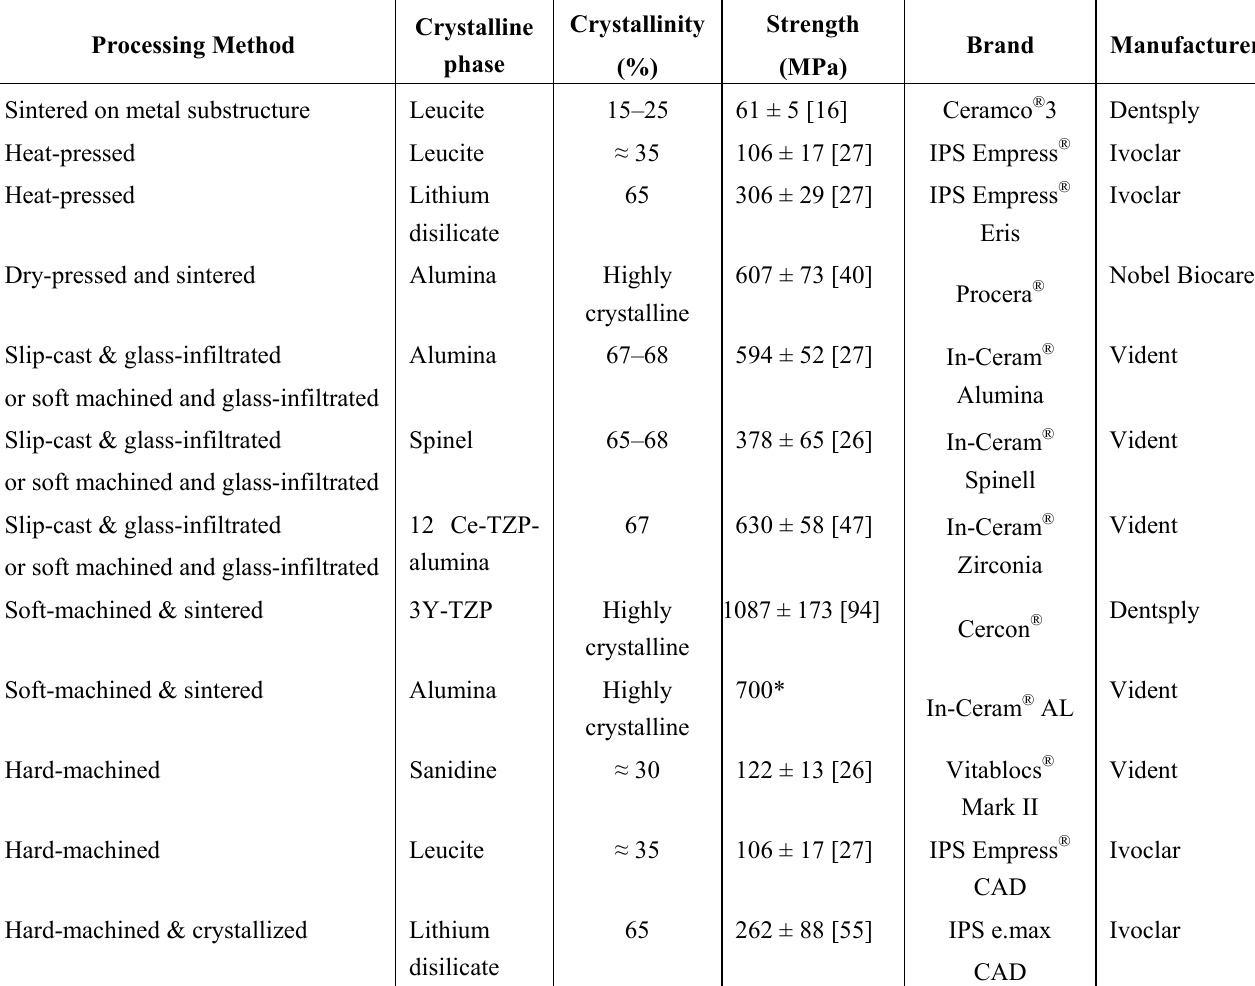
Table 2. Systems available for metal-ceramic and all-ceramic dental